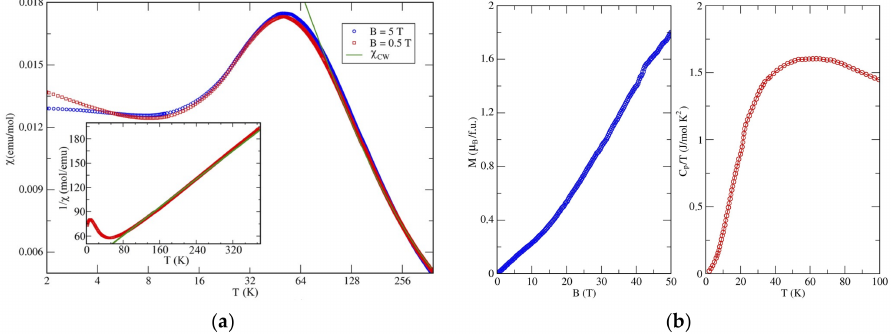
Figure 21. ( a ) Magnetic susceptibility χ (T) for KCu 5 O 2 (SeO 3 ) 2 Cl 3 obtained at different values of the external magnetic field in the field-cooling regime. The inset shows the Curie–Weiss approximation in the 100–380 K temperature range with the parameters θ = 60 K and C = 2.3 emu K/mol, as denoted by the green line. ( b ) The magnetization curve measured at T = 1.5 K. (left) Temperature dependence of the specific heat, C p (T)/T, for KCu 5 O 2 (SeO 3 ) 2 Cl 3 measured in zero field. Reproduced from